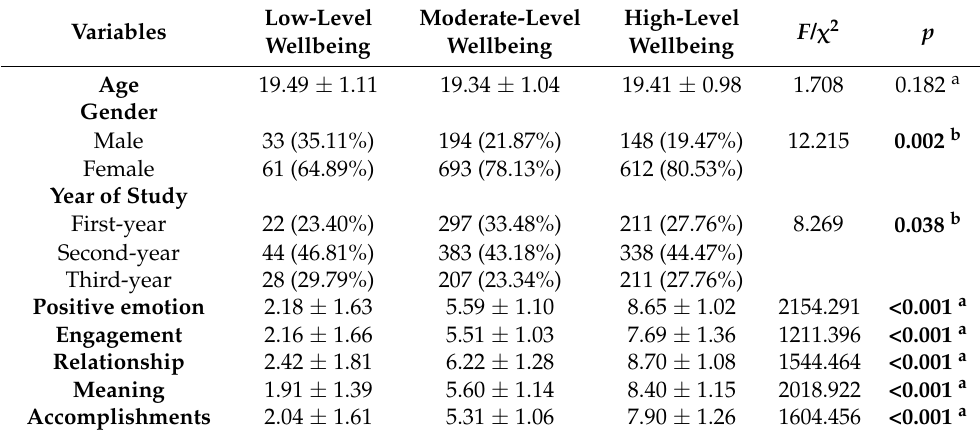
Table 3. Comparison of demographic characteristics and PERMA elements by latent classes (n =